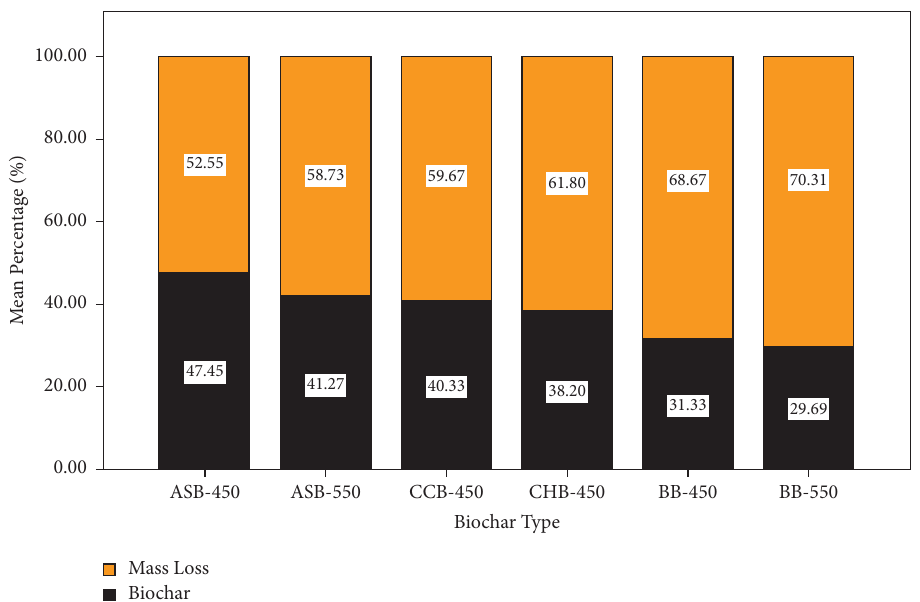
Figure 2: Efect of pyrolysis temperature and feedstock type on biochar yield.